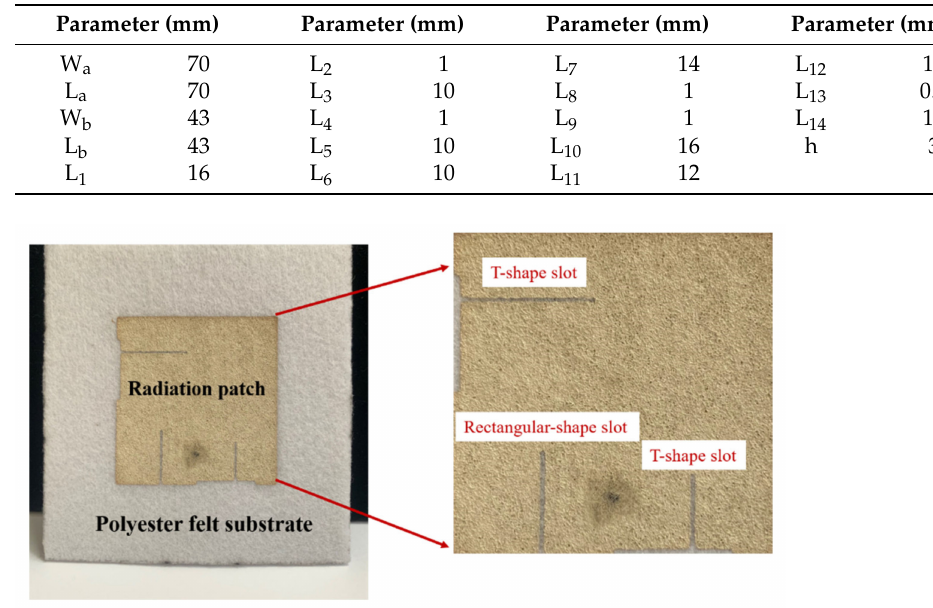
Figure 3. The detailed size of the final slotted antenna. Table 1. Dimension parameters of the slotted antenna.